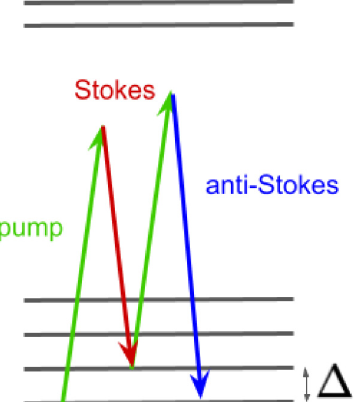
Fig. 1. Scheme of the coherent anti-Stokes Raman scattering event: an absorption of two photons of the probe beam along with a stimulated emission of a photon in the Stokes beam results in a coherent emission of a photon at the anti-Stokes frequency. Black lines represent molecular energy levels, e.g., associated with its vibrational structure. Note that the sample is illuminated with two, pump and Stokes fi elds, while the anti-Stokes radiation is generated through the nonlinear